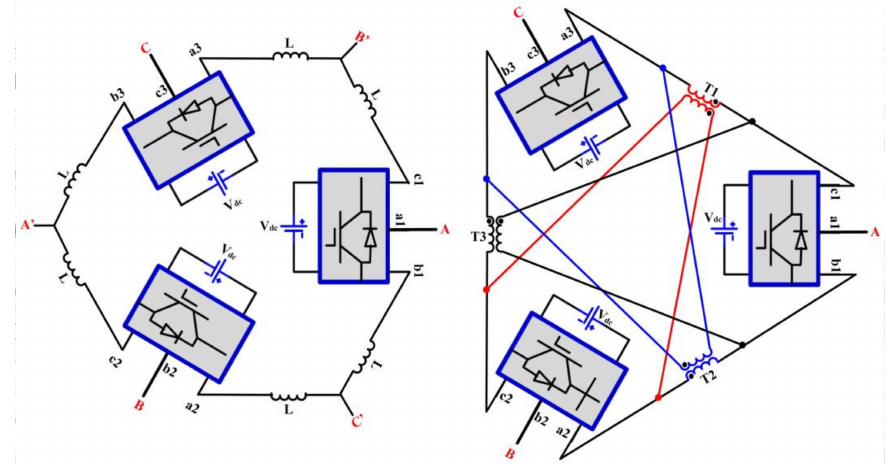
Figure 1. The multilevel converters presented in References [17] ( right ) and [20] ( left ).